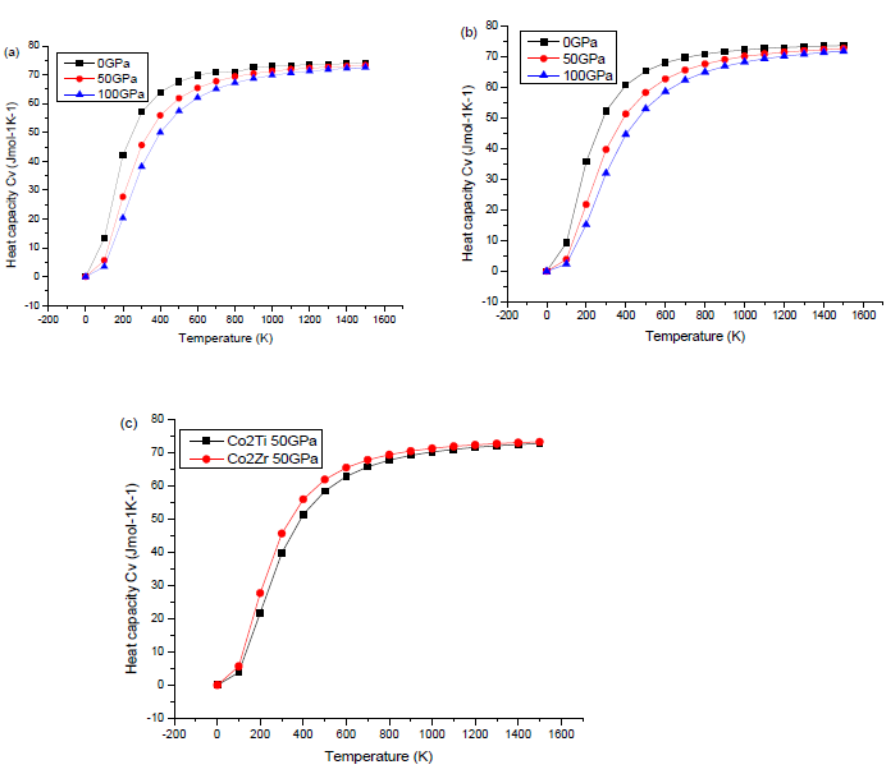
Figure 4. The heat capacity C V of ( a ) Co 2 Zr and ( b ) Co 2 Ti versus temperature at 0, 50, and 100 GPa; ( c ) the heat capacity C V of Co 2 Zr and Co 2 Ti versus temperature at 50 GPa.